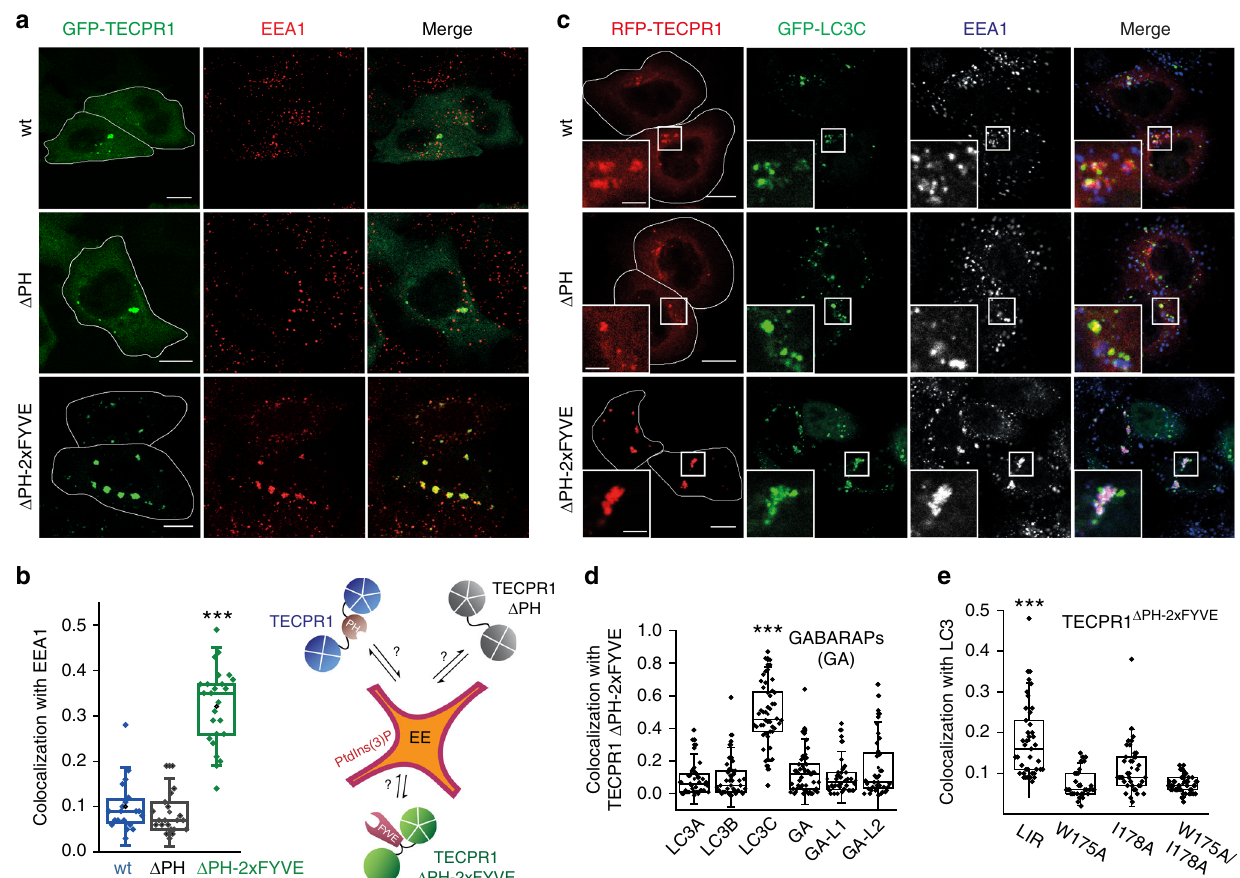
Fig. 5 TECPR1 determines the subcellular destination of LC3C autophagosomes. a Colocalization of GFP-TECPR1, GFP-TECPR1 Δ PH or GFP-TECPR1 Δ PH- 2xFYVE with immunostained EEA1 in TECPR1 KO cells. Scale bars, 10 µ m. b Quanti fi cation of colocalization as shown in a , n = 20 cells pooled from three independent experiments. Box plots represent the fi rst (25%) and third (75%) quartiles, respectively. The center line represents the median, whiskers the standard deviation and minima and maxima are available from the Source Data fi le. P -values were calculated using a two-tailed Student ’ s t -test (*** P < 0.001). c Confocal images of starved TECPR1 KO cells coexpressing GFP-LC3C and either RFP-TECPR1, RFP-TECPR1 Δ PH or RFP-TECPR1 Δ PH-2xFYVE that were Supplementary Fig. 5e. n = 40 cells pooled from three independent experiments. Box plots represent the fi rst (25%) and third (75%) quartiles, respectively. The center line represents the median, whiskers the standard deviation and minima and maxima are available from the Source Data fi le. P - values were calculated using a two-tailed Student ’ s t -test (*** P < 0.001). e Quanti fi cation of colocalization between GFP-TECPR1 Δ PH-2xFYVE or its LIR mutants with LC3 as shown in Supplementary Fig. 5f, n = 32 cells pooled from three independent experiments. Box plots represent the fi rst (25%) and third (75%) quartiles, respectively. The center line represents the median, whiskers the standard deviation and minima and maxima are available from the Source Data fi le. P -values were calculated using a two-tailed Student ’ s t -test (*** P < 0.001). See also Supplementary Movie 5. Source data are provided as a Source Data fi